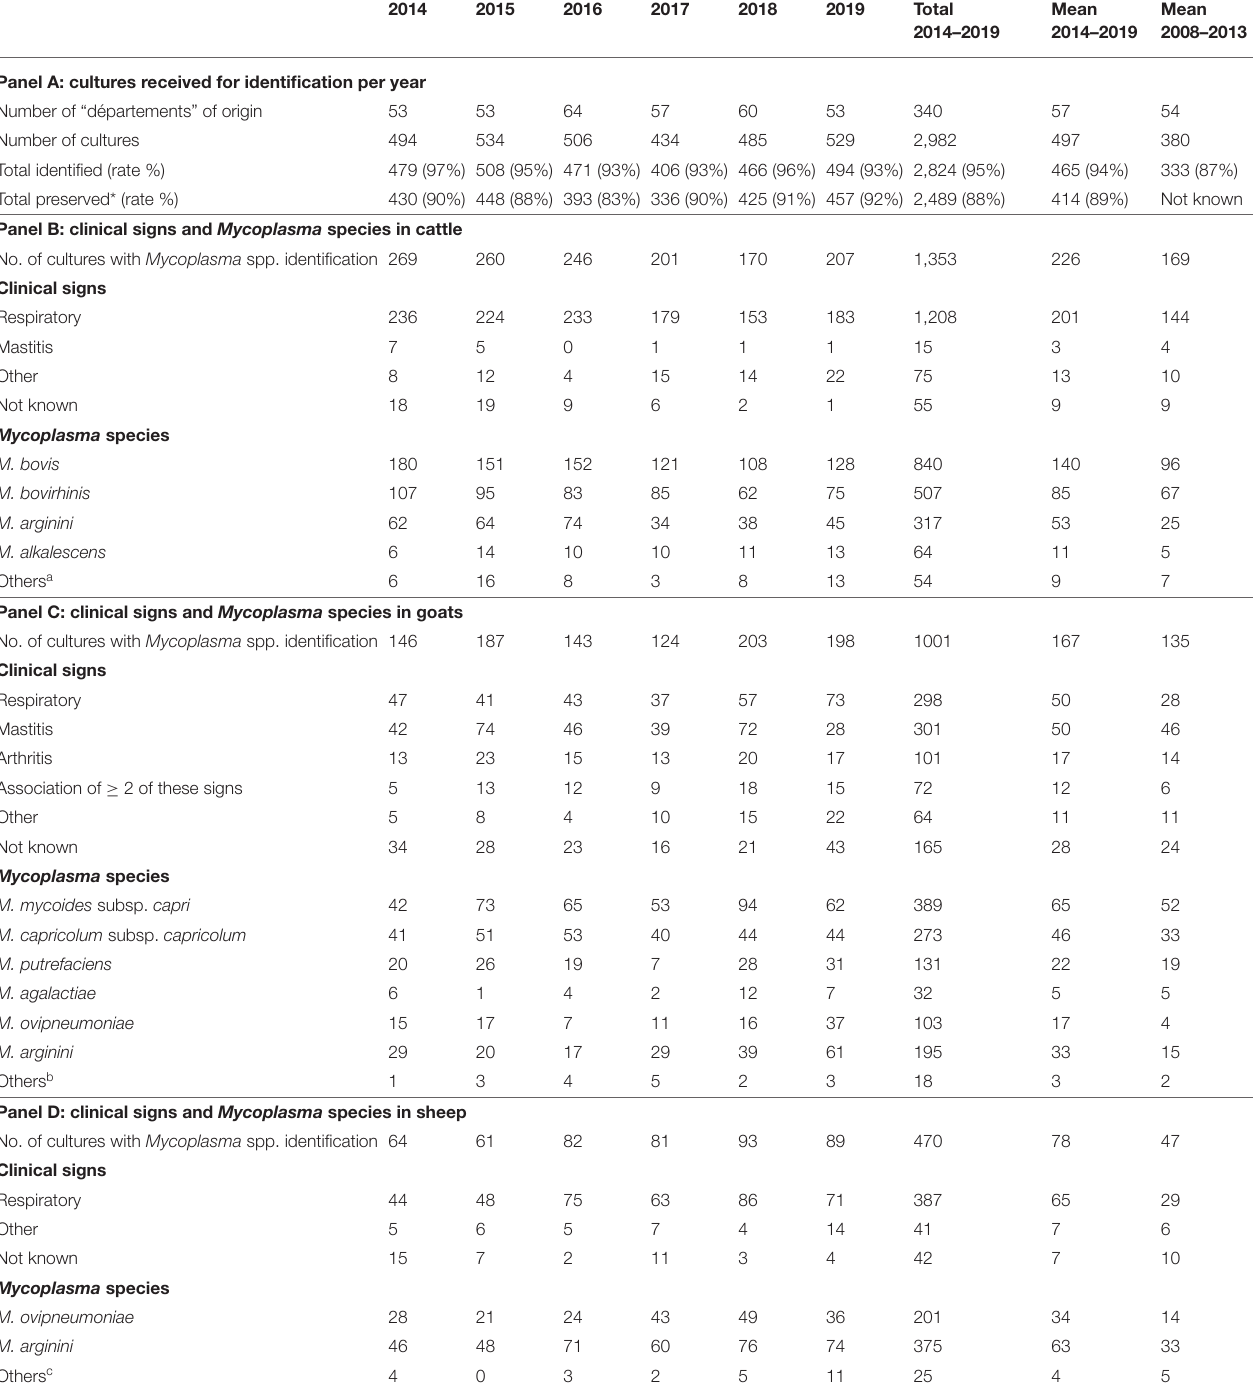
TABLE 1 | Vigimyc surveillance results over the 2014–2019 period in cattle, sheep and goats, including dominant clinical signs, Mycoplasma species identified, and number of isolates preserved in